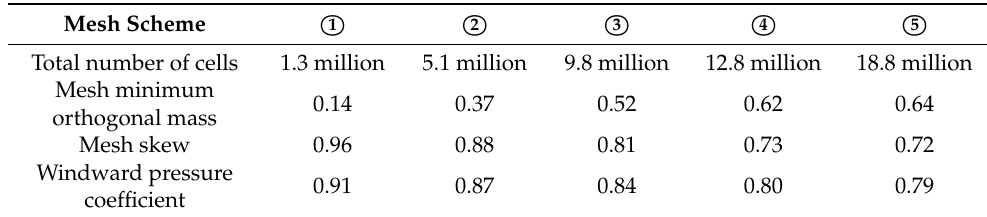
Table 2. Mesh quality and pressure coefficient of the windward surface of the tower throat area under different mesh